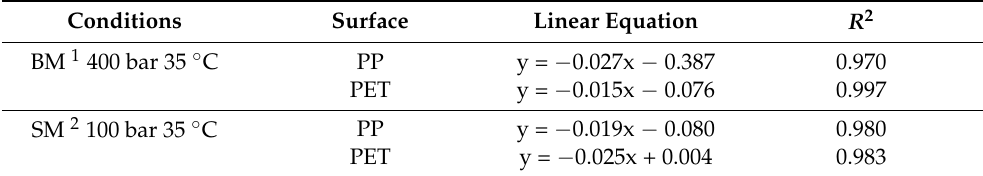
Table 3. Linear equations and correlation coefficients for first order kinetic